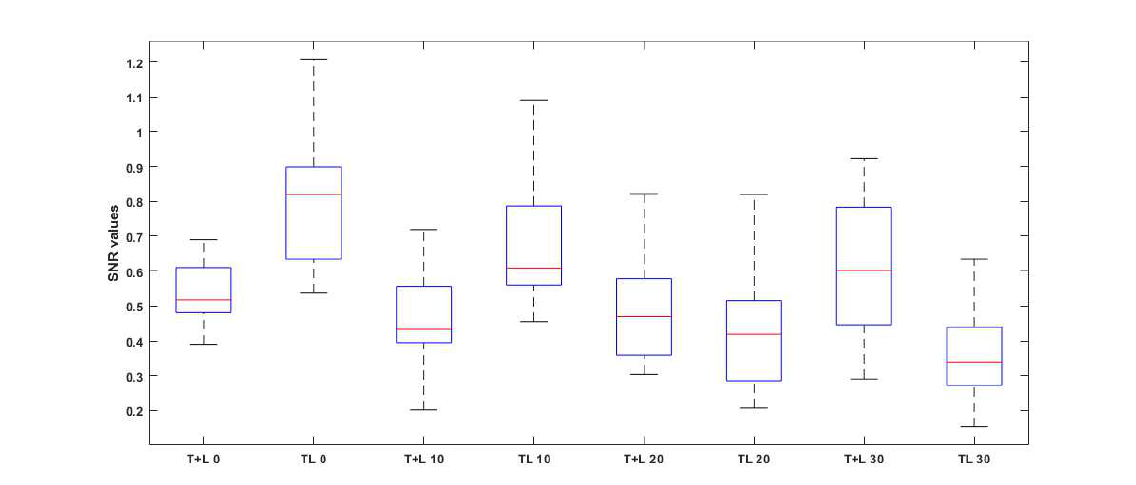
Figure 3. Box-plots of the SNR T + L and SNR TL values computed from the re-sampled error rates of T+L and TL cases, respectively, for the four azimuthal angles studied. Note that the SNR values of time and level cues are combined into SNR TL super-additively for 0 ◦ and 10 ◦ , whereas their combination turns to be additive and sub-additive for 20 ◦ and 30 ◦ ,